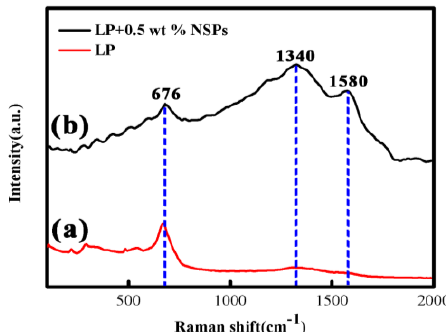
Figure 5. Raman spectra of the worn surface of friction pairs under the lubrication of LP ( a ) and LP + 0.5 wt % NSPs ( b